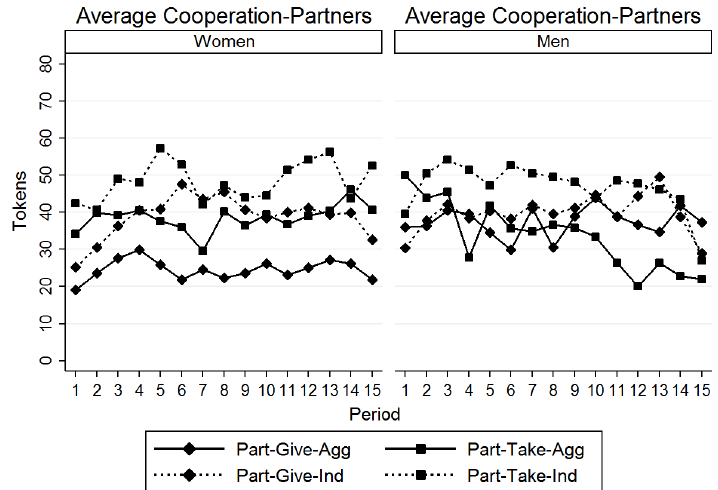
Figure 7. Average Cooperation Over Time